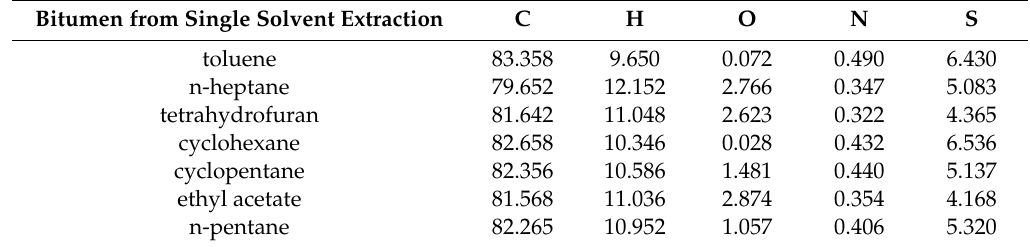
Table 3. The elemental analysis of bitumen (wt%) from single solvent extraction. Bitumen from Single Solvent Extraction